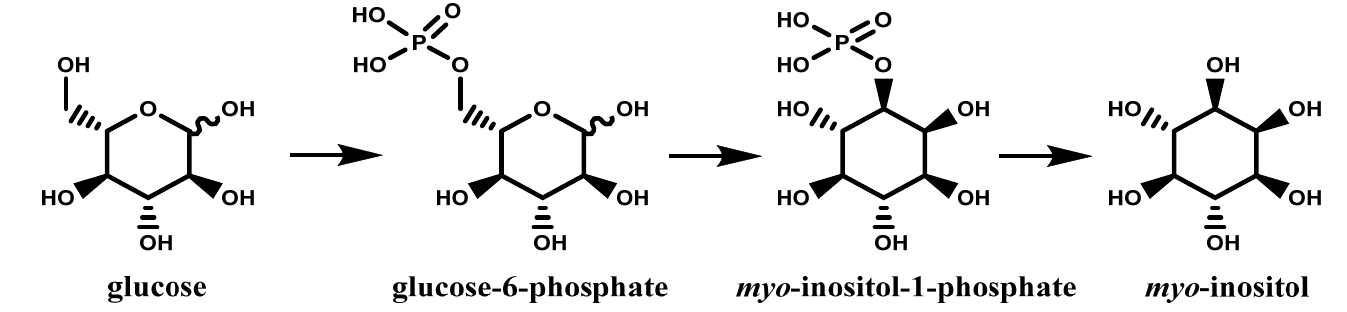
Figure 5. Biosynthesis of myo -inositol.